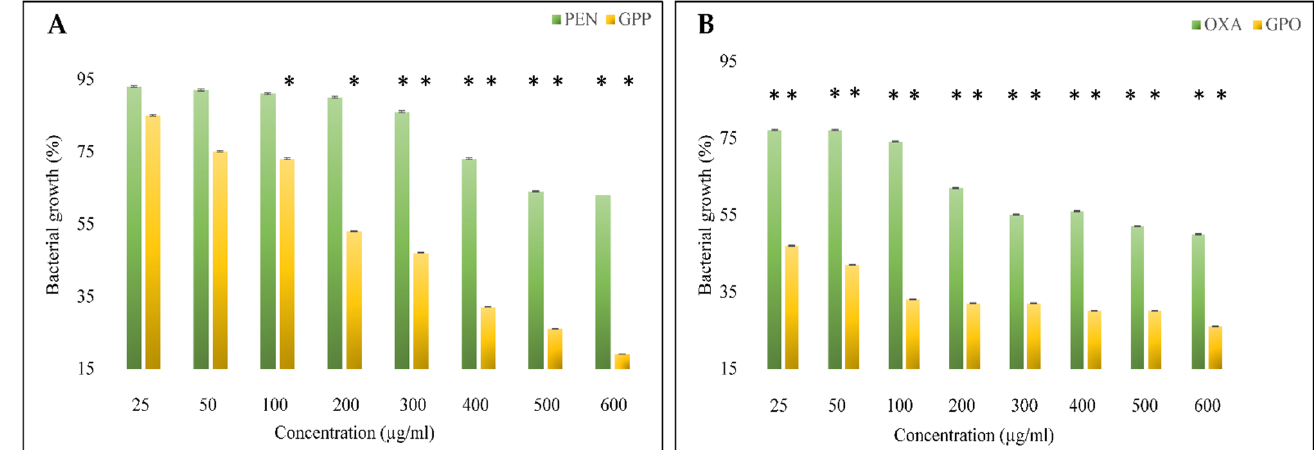
Figure 7. Bacterial growth inhibition of compounds tested against MRSA, ( A ) PEN and GO-PEG-PEN, ( B ) OXA, and GO-PEG-OXA. This chart shows that GO-PEG antibiotics significantly inhibit bacterial growth compared to free antibiotics. (* means p ≤ 0.05). Table 3. MIC values of the compounds against